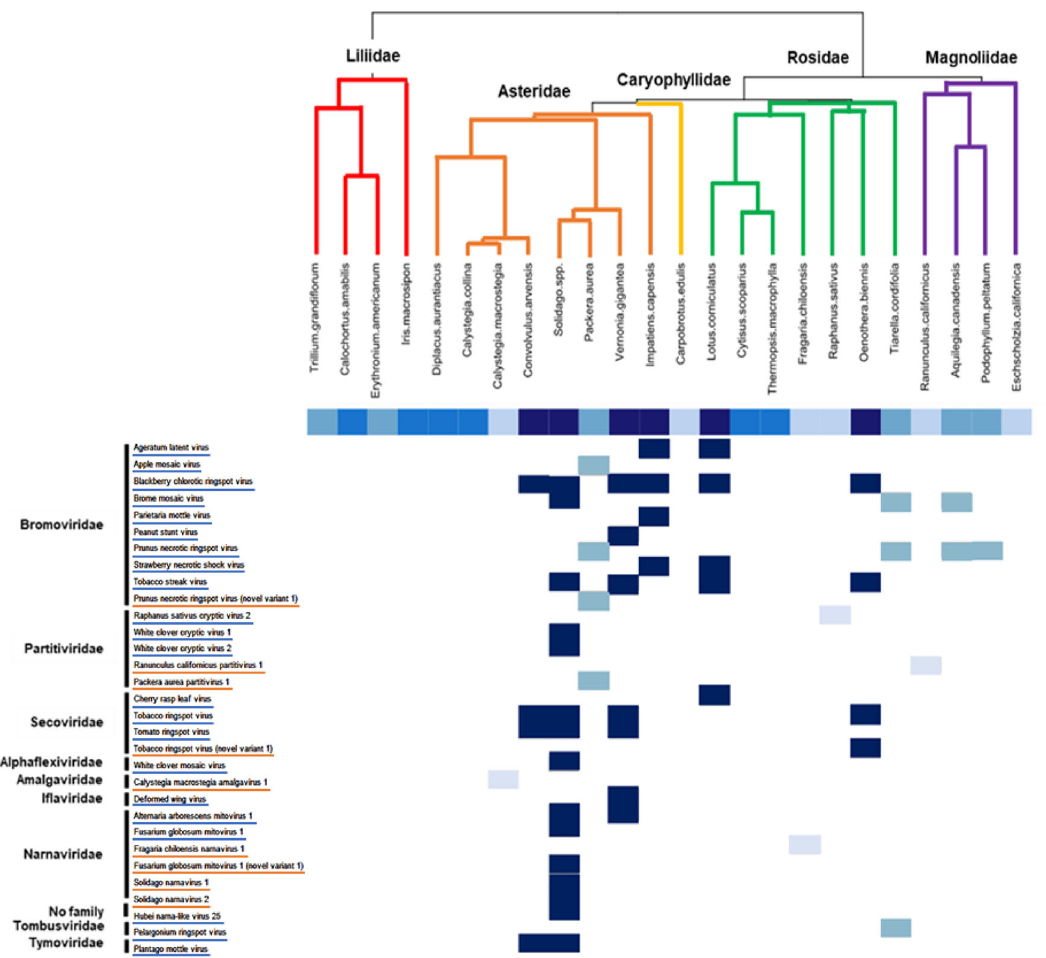
Fig. 3 Pollen-associated known viruses, novel coding-complete viral genomes, and novel variants of known viruses grouped by family (right), plant species (top) and geographic region (central boxes). Known viruses (blue underline), are referenced by their species name. Novel coding-complete viral genomes and variants (orange underline) are referenced by the plant species in which they were discovered and the virus family to which they belong. Plant subclasses are indicated by color on the dendrogram. Presence of a virus in a plant species is indicated by a box with the color indicating the geographic region of collection (navy blue = EDAFI, medium blue = CA, light blue = CC). Source data are provided as a source data fi